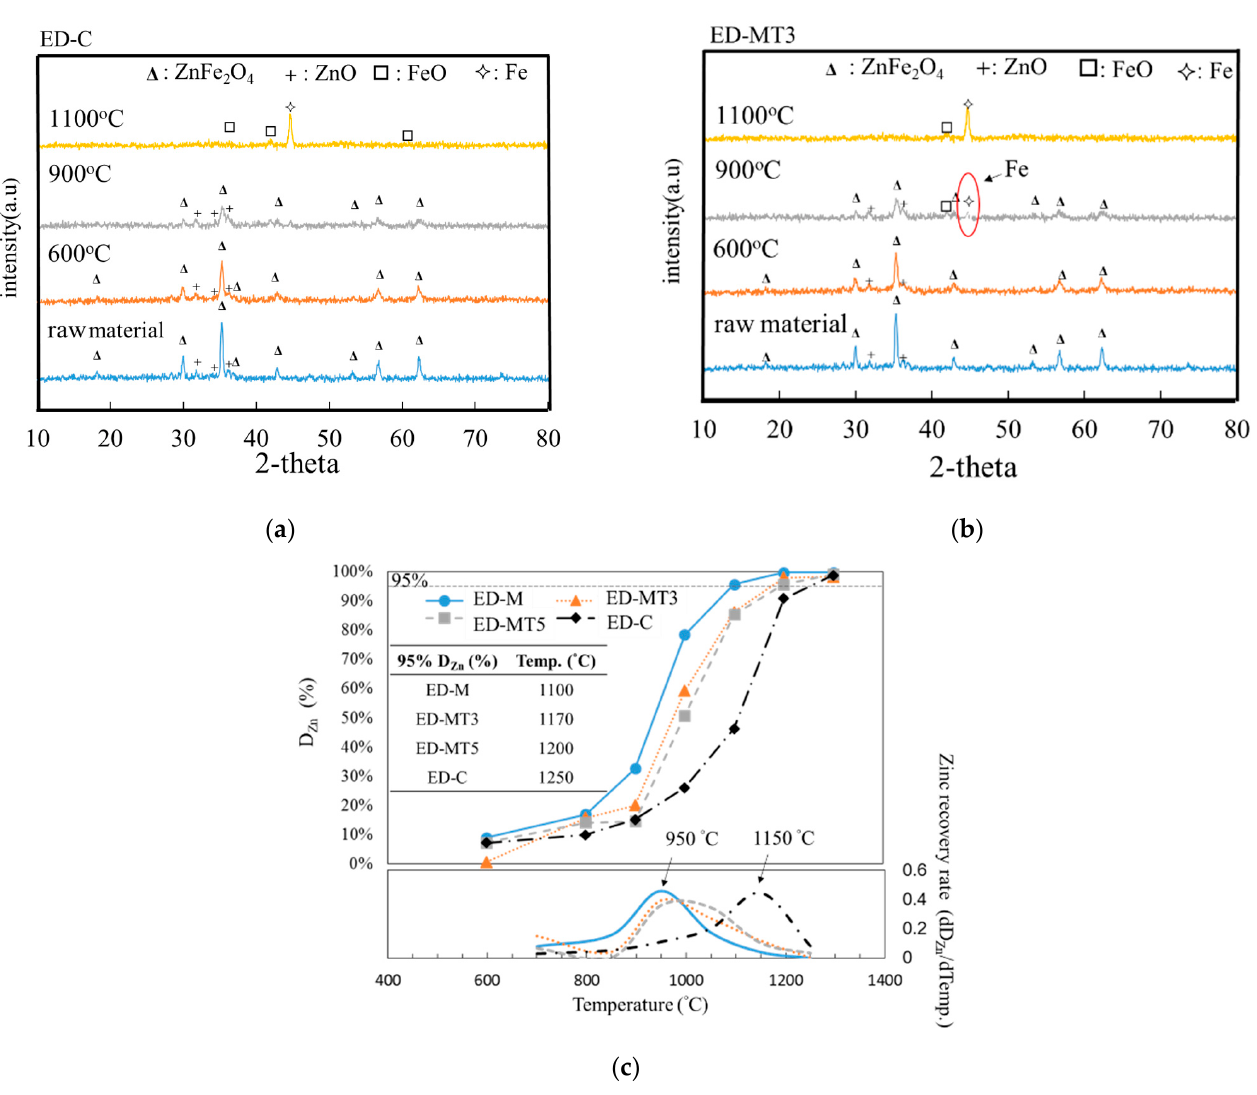
Figure 1. Carbothermic reduction of EAFD/SMS (ED-MT3) and EAFD/Coke (ED-C) composite samples with molar C/O = 0.8. ( a ) XRD patterns of ED-C samples interrupted at 600 °C, 900 °C, and 1100 °C during reduction process; ( b ) XRD patterns of ED-MT3 samples interrupted at 600 °C, 900 °C, and 1100 °C during the reduction process; ( c ) The upper curves showed the degree of zinc removal (%) defined in Equation (1) and the lower curves showed zinc recovery rate (dD Zn %/dTemp.). The recovery rate is defined as the derivative of upper curve, which is the derivative of the degree of removal with respect to temperature. The results show that the EAFD/SMS composite samples have the maximum recovery rate at about 950 °C, while the EAFD/C sample is about 1150 °C. This observation quantitatively suggests that SMS as a reducing agent (in place of coke) can lower the reduction temperature by about 200 °C.